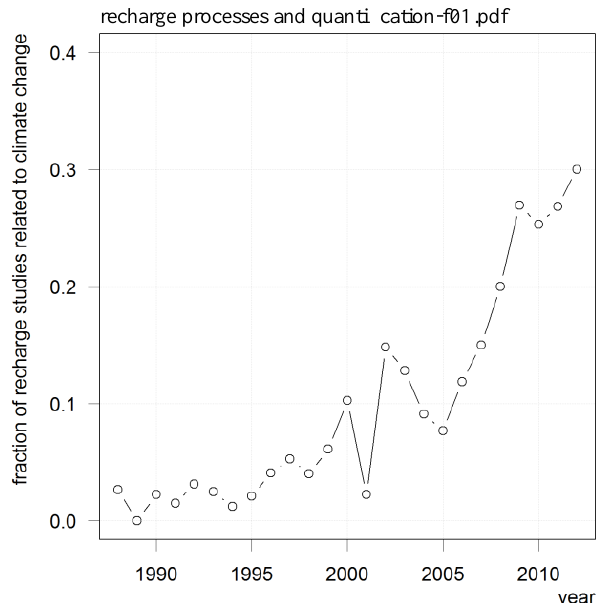
Fig. 1. Number of studies with “groundwater recharge” and “cli- Figure 1: number of studies with “groundwater recharge” and “climate change” in the mate change” in the keywords relative to those with only “ground- water recharge”. Based on statistics in Scopus as of 24 April keywords relative to those with only “groundwater recharge”. Based on statistics in Scopus as of April 24th 2013.